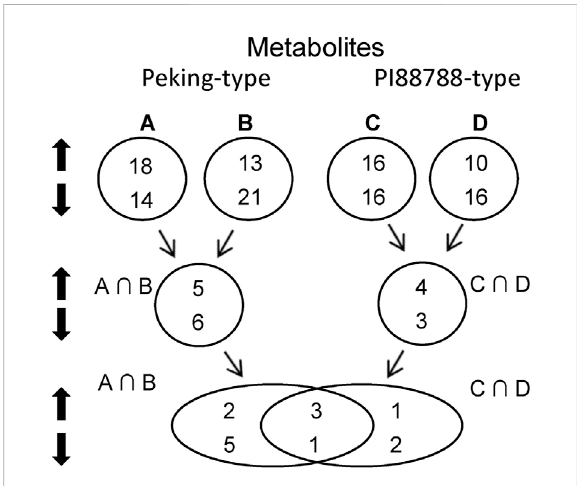
FIGURE 2 Bulk strategy and number of signi fi cant differentially expressed metabolites (DEMs) between Peking- and PI 88788- type sources of resistance. A, Peking versus (vs.) Hutcheson; B, Pool-a vs. Pool-c: the pool of PI 90763, PI 404166, PI 89772, PI 437654, and PI 438489B vs. the pool of Williams 82 and Magellan; C, PI 88788 vs. Hutcheson; D, Pool-b vs. Pool-c: the pool of PI 437655, PI 495017C, PI 209332, PI 438503A and